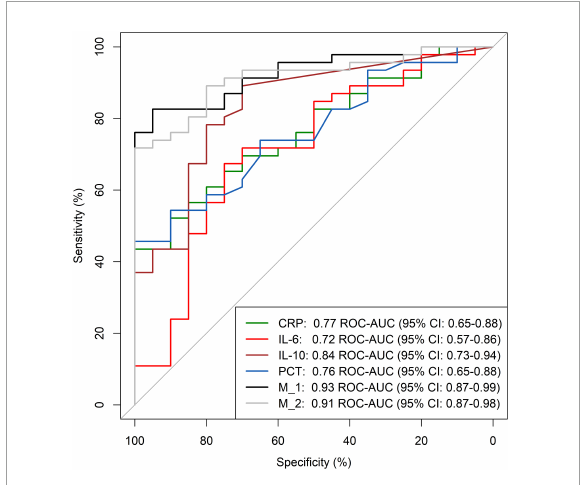
FIGURE1 ROC analysis for detection of additional infections in COVID-19 ICU patients. ROC-AUC, area under the receiver operating characteristics curve; 95% CI, 95% Confidence interval; CRP, C-reactive Protein; IL-6, Interleukin-6; IL-10, Interleukin-10; PCT, Procalcitonin; M_1 (model 1) and M_2 (model 2), multivariate step-wise regression models. M_1 included CRP, IL-6, IL-10 and procalcitonin. M_2 included CRP and